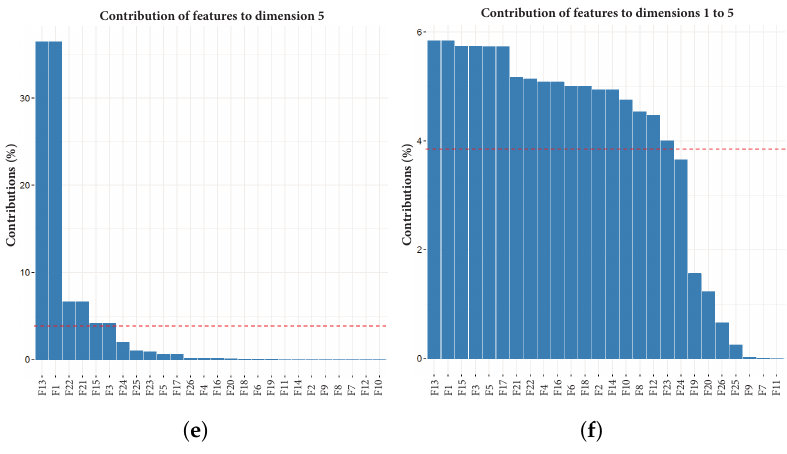
Figure 4. PCA results for user 1. Each graph represents the contribution of every feature to data variability in ( a ) dimension 1; ( b ) dimension 2; ( c ) dimension 3; ( d ) dimension 4; and ( e ) dimension 5; ( f ) contribution of every feature in the aggregated five dimensions.